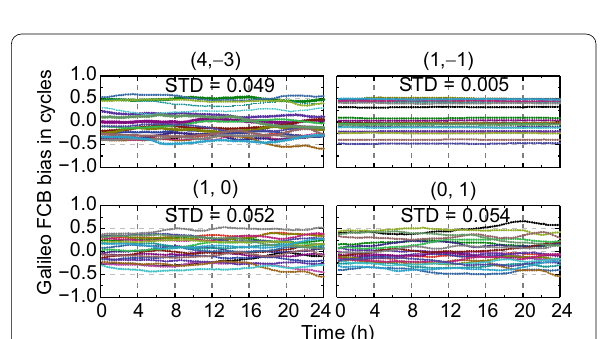
Fig. 7 Galileo FCBs series for the (4, individuals of each frequency. Each color denotes one satellite FCB series